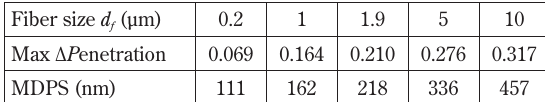
Table 4 The maximum penetration difference be- tween spheres and agglomerates and the cor- responding most differentiating particle size (MDPS) at different fiber sizes